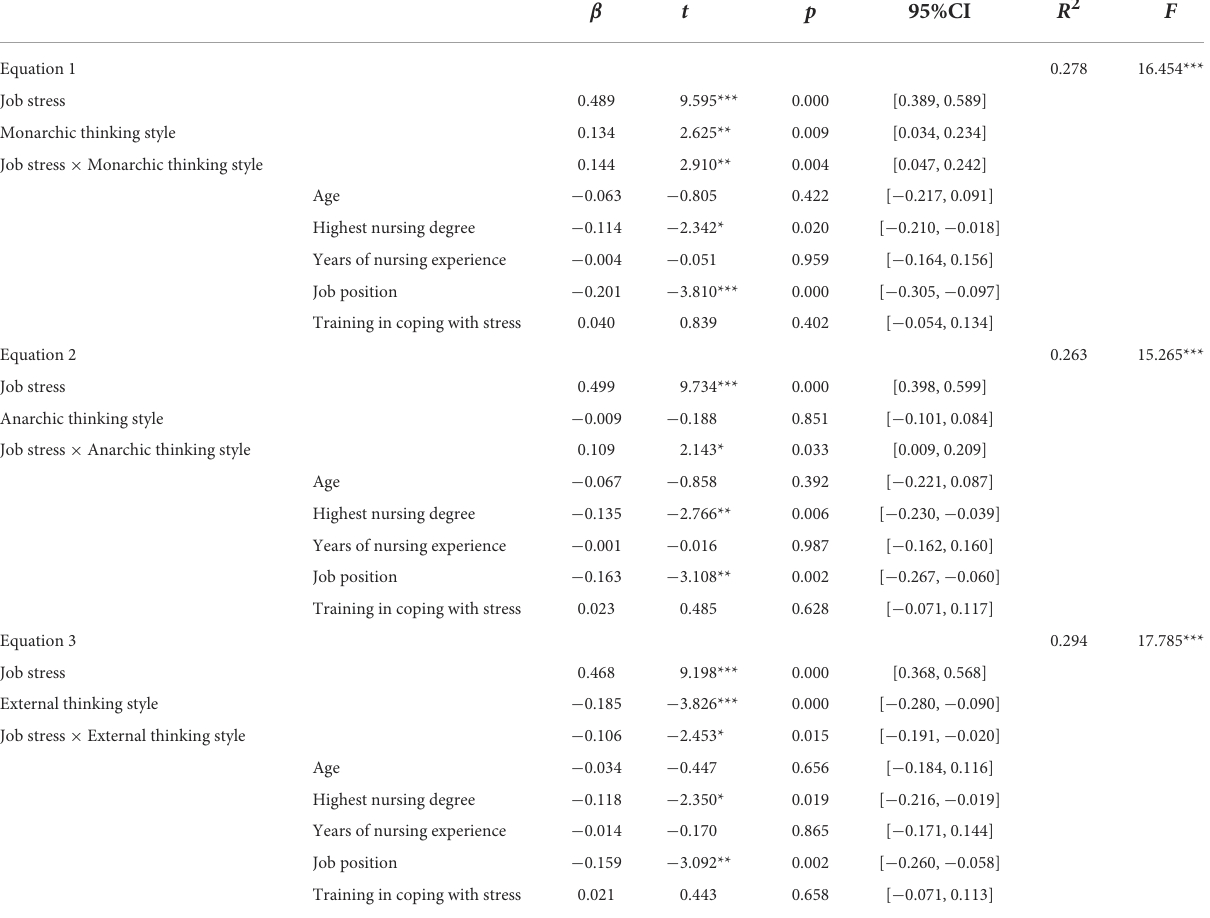
TABLE 3 Moderated Effect of Job stress on